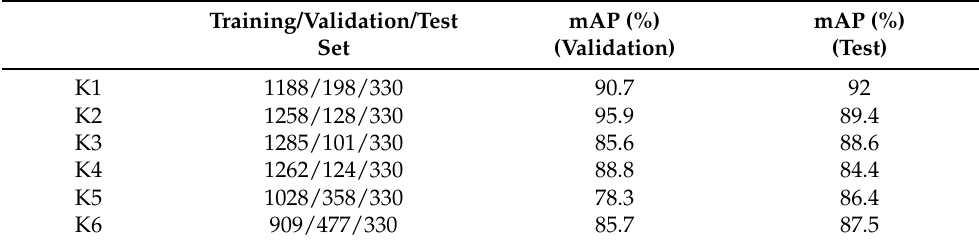
Table 5. mAP values for Model 3 trained one of six partitions of the Klim dataset. These six models form the ensemble model.